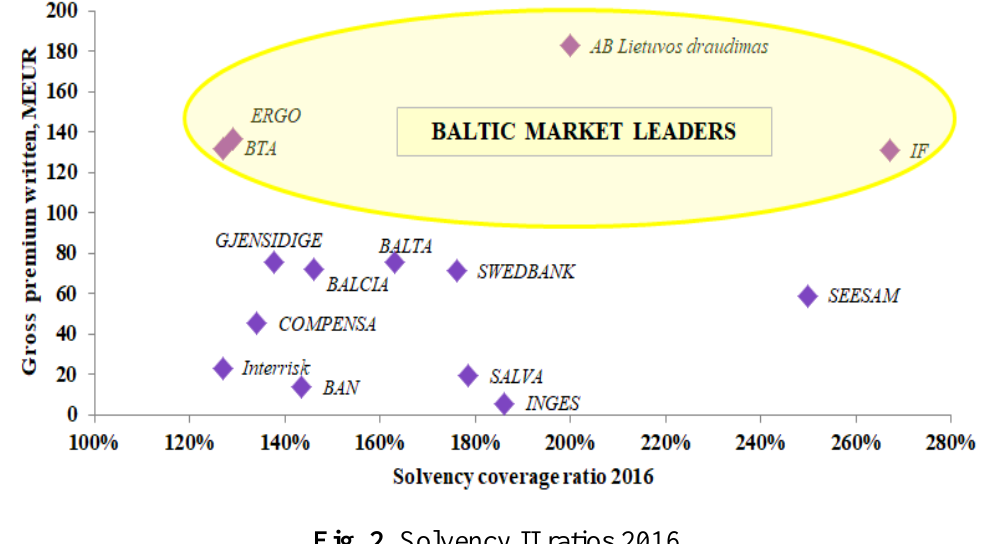
Fig. 2 . Solvency II ratios 2016.